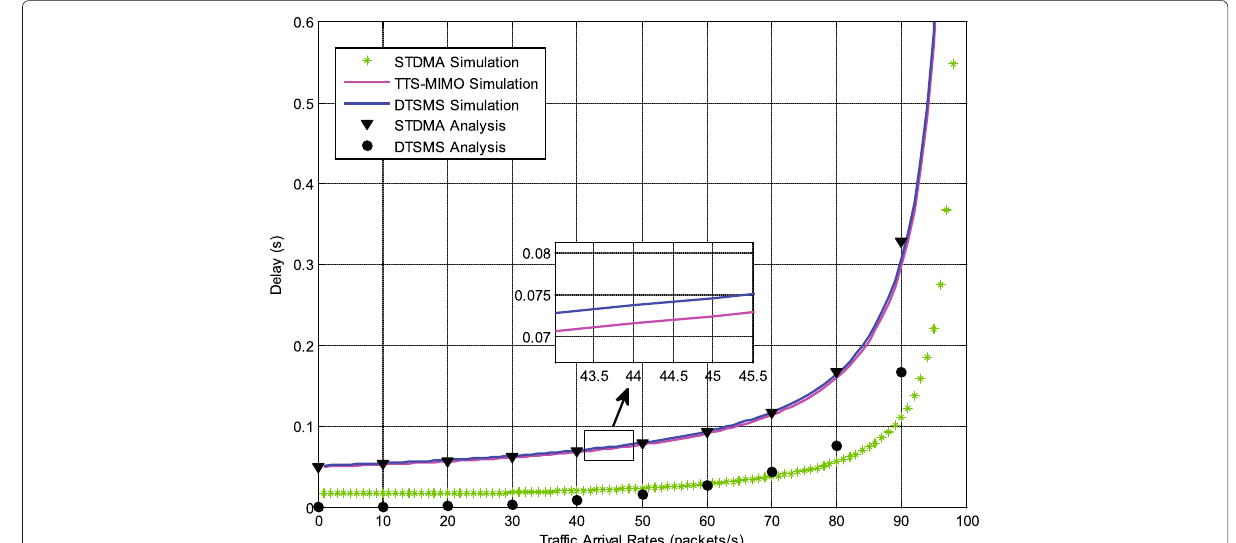
Fig. 10 Delay with different traffic arrival